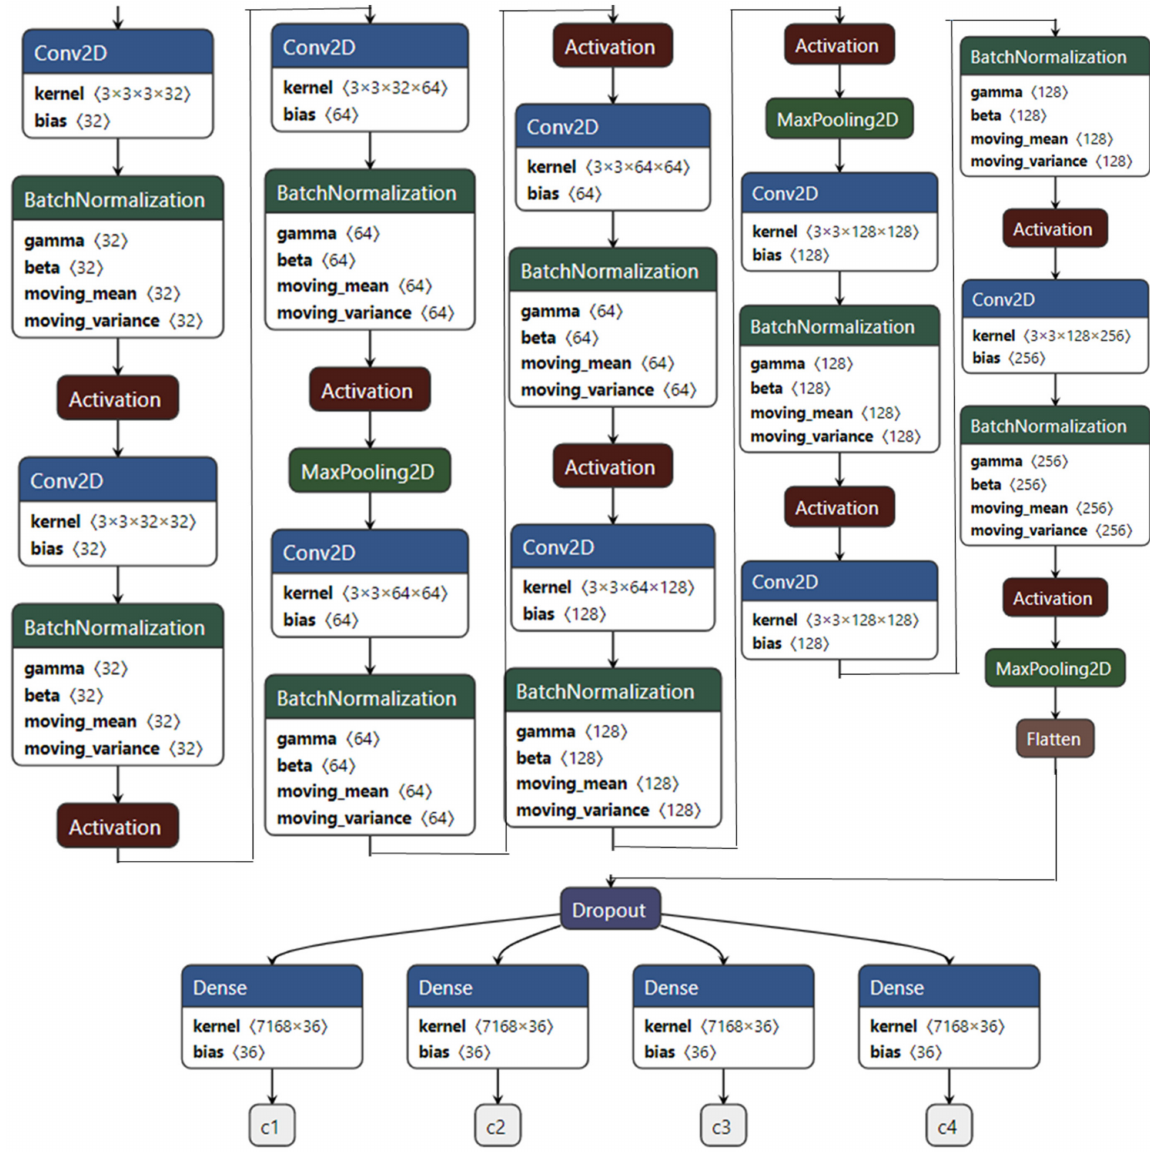
Figure 5. The network structure of the proposed CNN solver